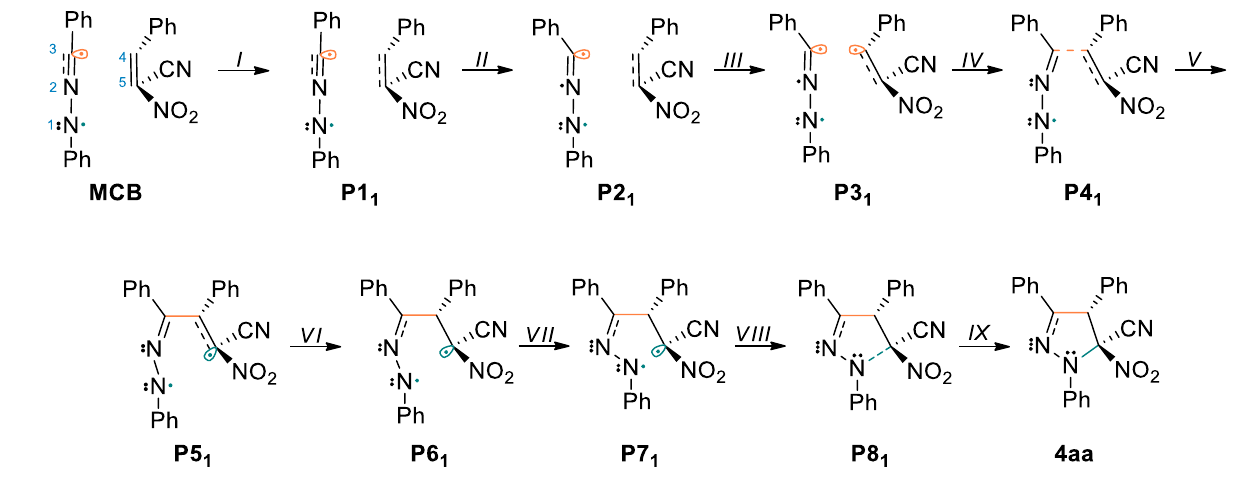
Scheme 6. The proposed molecular mechanism of the 32CA reaction between 1a and 2a . Table 6. BET analysis results for the 32CA reaction of the 1a with 2a . The table also lists the